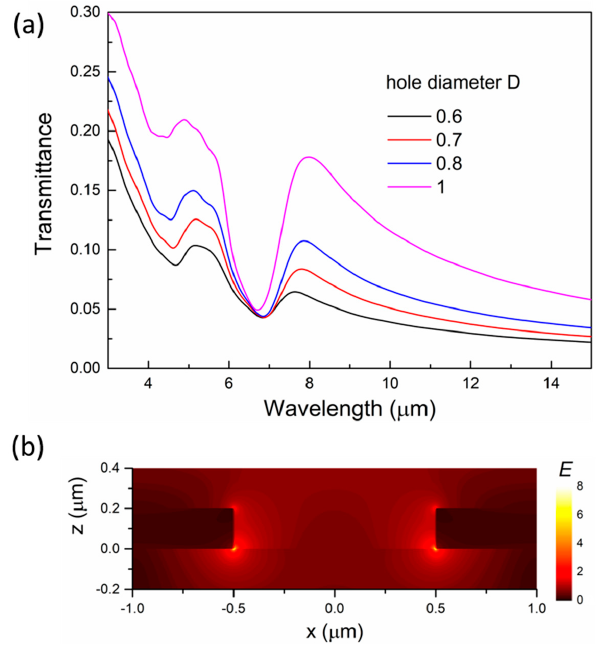
Figure 4. The optical properties of ITO nanohole arrays. ( a ) The reflectance spectra of the ITO nanohole arrays with di ff erent hole diameters. The periodicity of the arrays is 2 µ m. ( b ) The electric near-field distribution of the nanohole at 8 µ m. The diameter of the nanohole is 1 µ m, and the color bar shows the magnitude of the electric